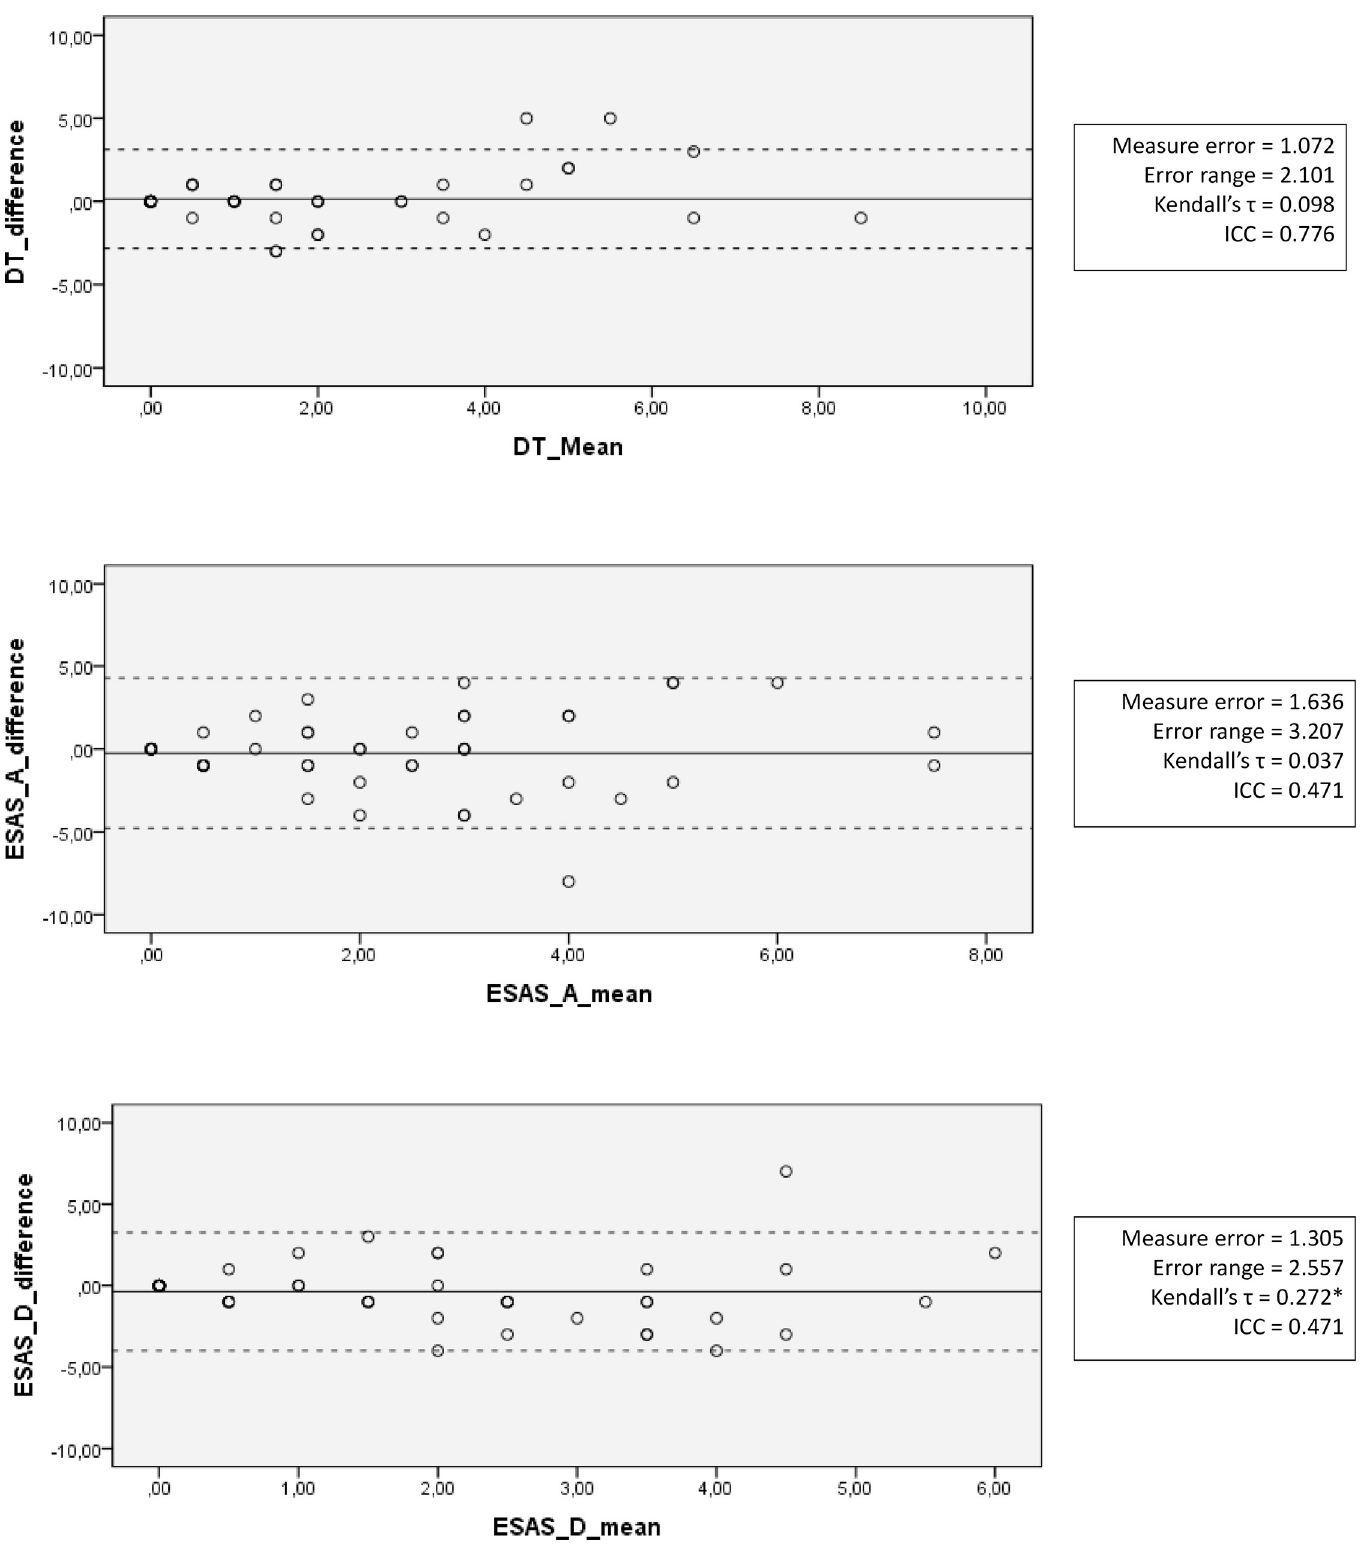
Fig 1. Repeatability analysis of the DT, ESAS-R-A and ESAS-R-D over a 1-month interval. Differences are raw values of T2-T1. Dotted lines indicate the limits of agreement for each measure (M ± 1.96 * SD), in which 95% of differences lie.